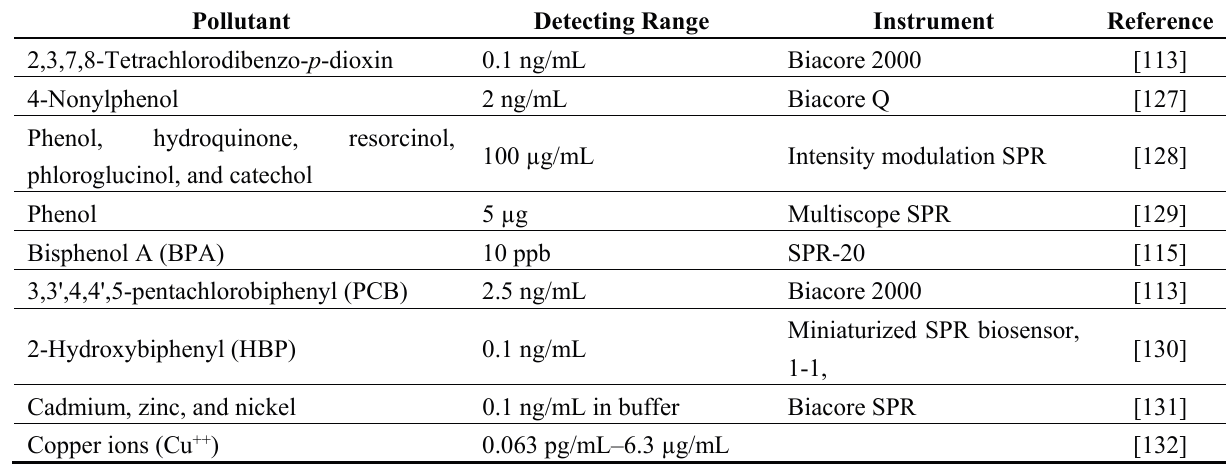
Table 4. SPR biosensor-based pollutant